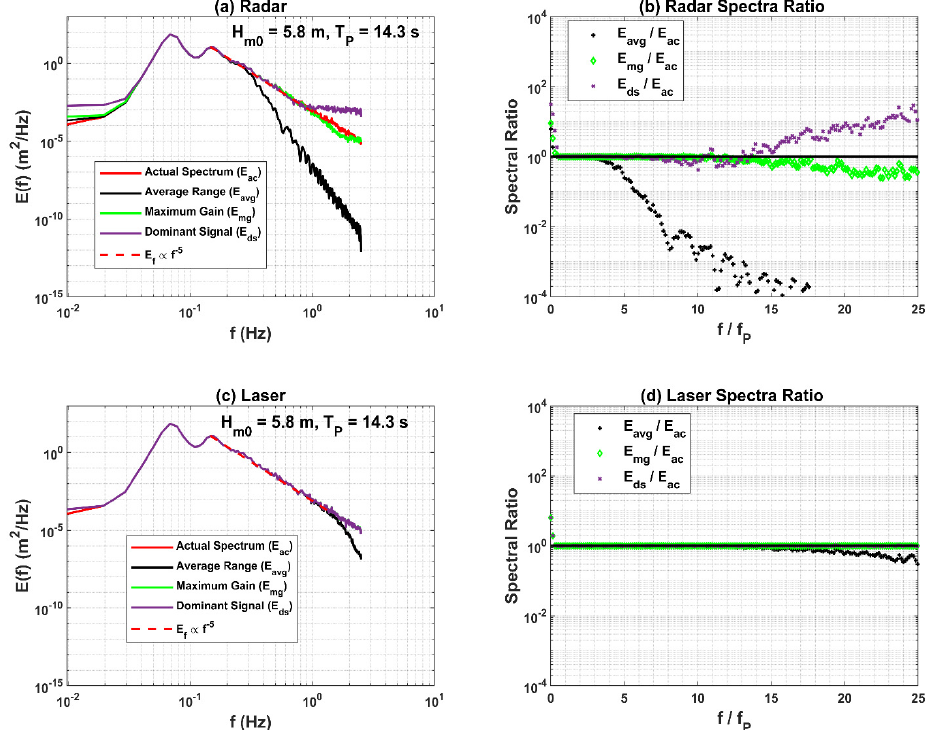
Figure 8. Comparison of one-dimensional frequency spectra estimated from actual surface elevations with the spectra derived from the simulated surface elevations of the Radar ( a , b ) and the Laser ( c , d ) from averaged ranges, ranges associated with maximum gain and dominant signals for a swell dominating sea state with a significant wave height ( H m 0 ) and peak frequency ( f P ) of 5.8 m and 0.07 Hz, respectively.